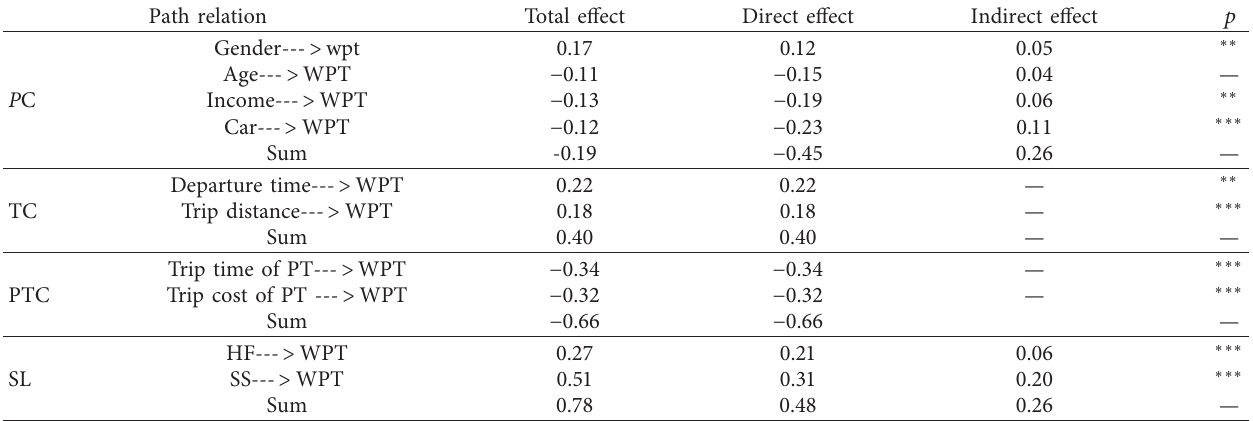
Table 10: Path coefficients among group variables.